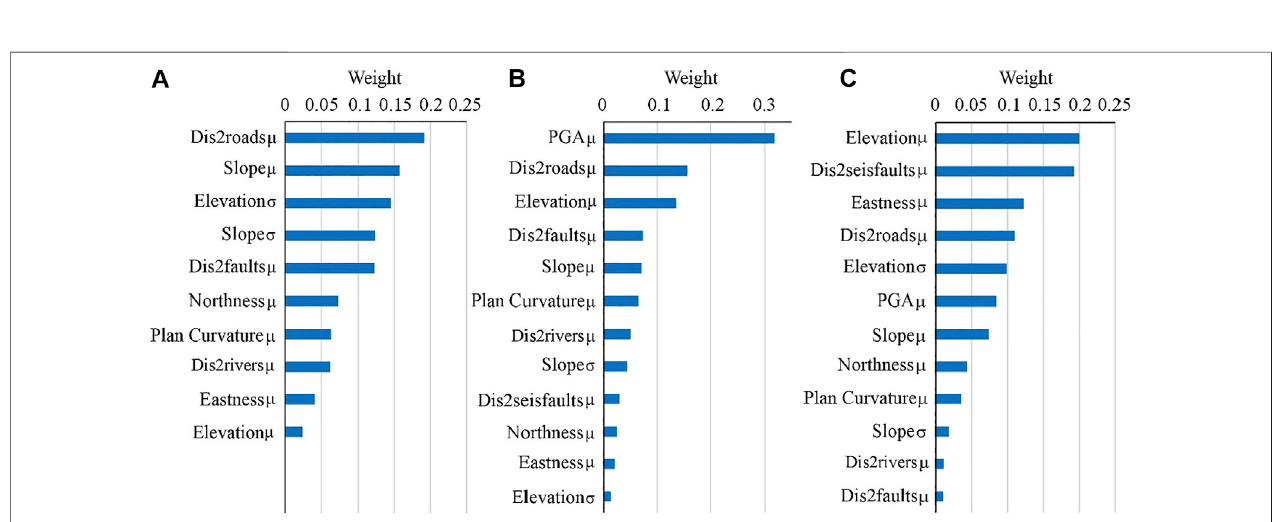
FIGURE 10 | Importance order of each signi fi cant covariate obtained for each model based on the regression coef fi cient. (A) Mod1, (B) Mod2, and (C) Mod3.